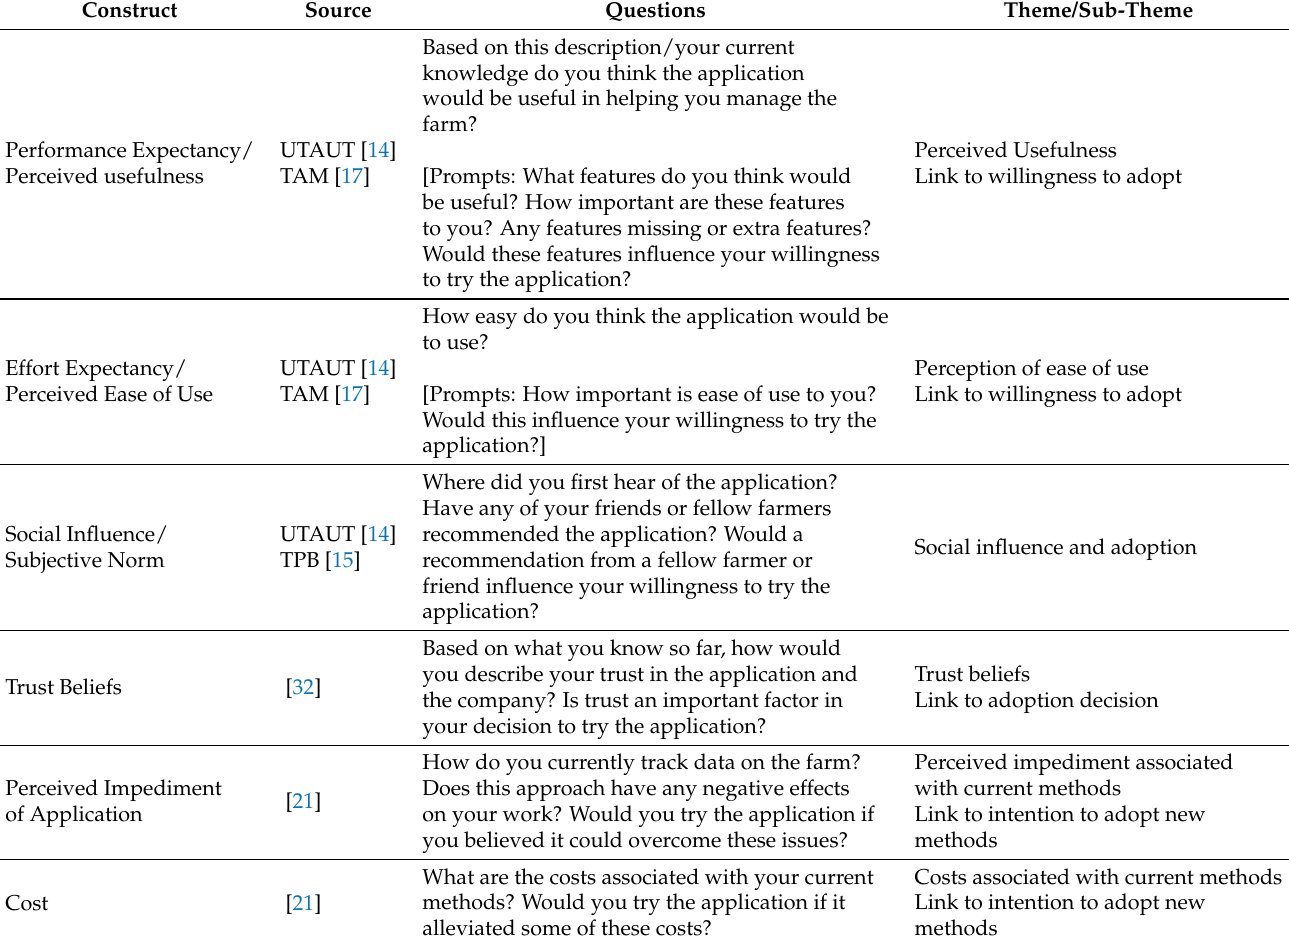
Table A2. Topic guide: Non-user focus group.